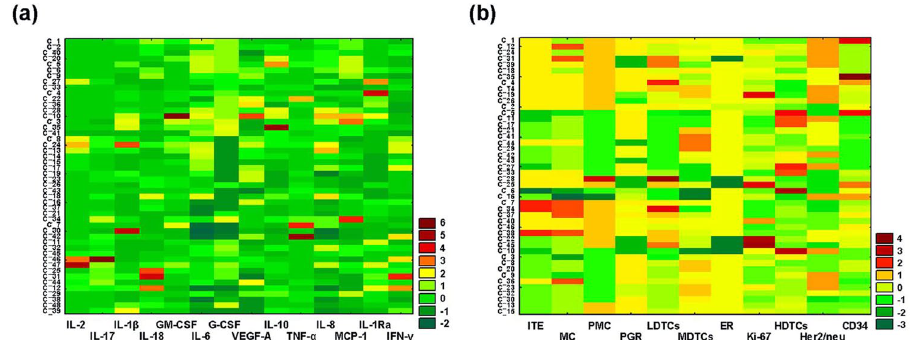
Figure 1. Graphical representation of the results of two-way joining cluster analysis of the data on cytokine production by IC-NST samples and IC-NST histopathological parameters. ( a ) The horizontal axis of the graph shows the cytokines involved in the classification (according to their production by IC-NST samples, pg/ ml), and the vertical axis indicates the encrypted numbers of IC-NST samples from different patients. ( b ) The graph shows horizontally the histopathological parameters involved in IC-NST classification, and vertically the encrypted numbers of IC–NST samples from different patients. The colors of the intersecting cells indicate that the matrix elements belong to a specific cluster. The color gradient from green to red respectively denotes an indicator’s value below or above the